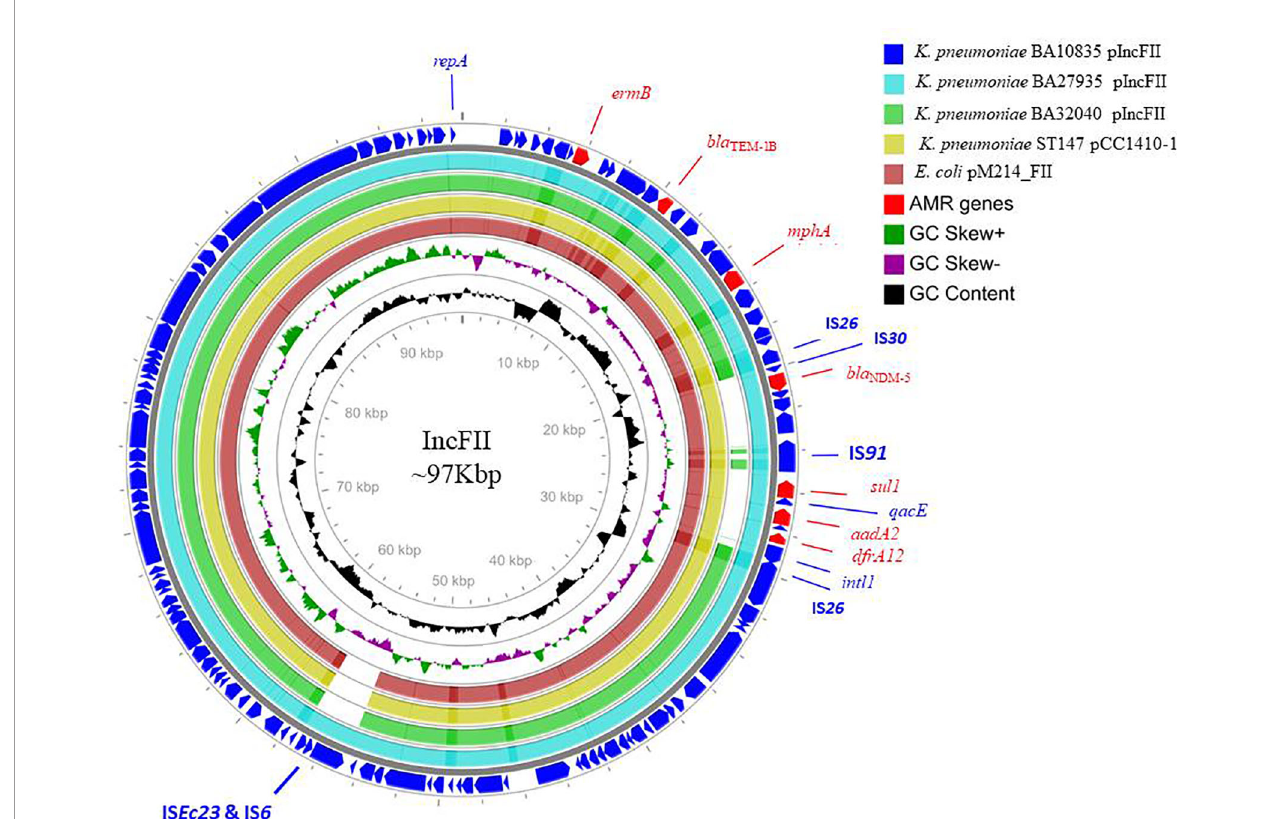
FIGURE 2 | Alignment of IncFII plasmids of three MDR hypervirulent K. pneumoniae belonging to ST2096. Circles from the outside to the inside show the CDS region of BA10835 (blue), BA27935 (cyan), BA32040 (green), and nearest matching reference plasmids that belong to K. pneumoniae pCC1410-1 (yellow; KT725788) and E. coli pM214 (red; AP018144). GC skew (dark green and magenta) and GC content (black) of the plasmid are represented in the inner circles. Maps were generated using the CGView